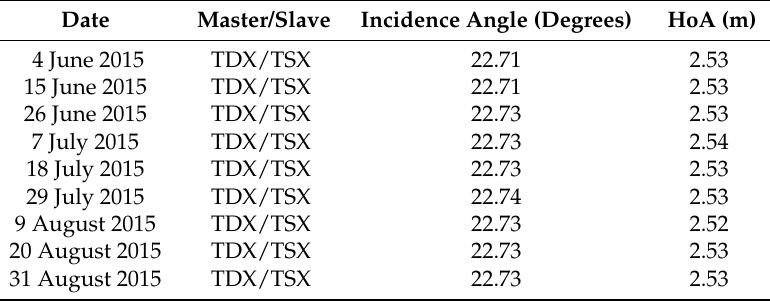
Table 2. List of TanDEM-X data takes (CoSSC